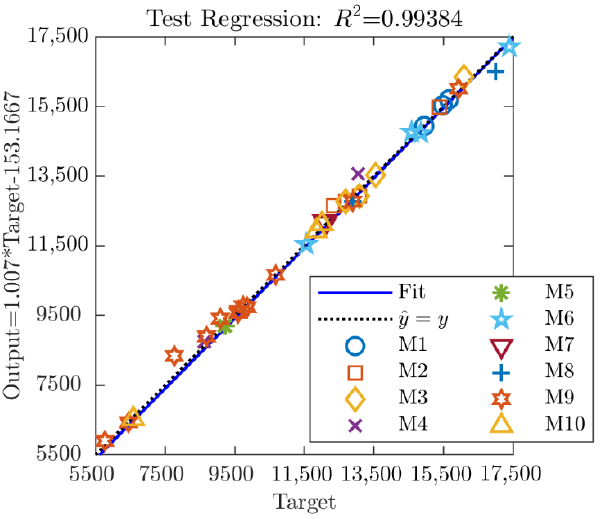
Figure 7. Linear regression analysis on the test set for the MS SNN .